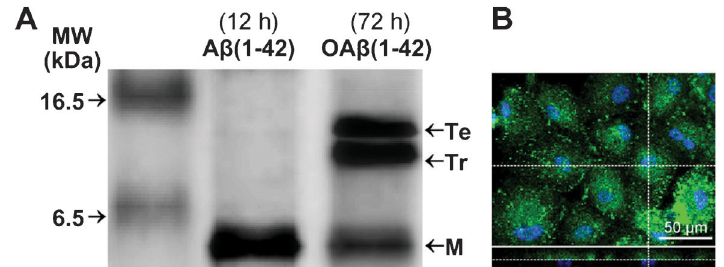
for ezrin (green) in human adult RPE cells. The presence of ezrin on the apical side of the RPE microvilli is shown in confocal cross-sectional images (bottom). Nuclei are stained with DAPI